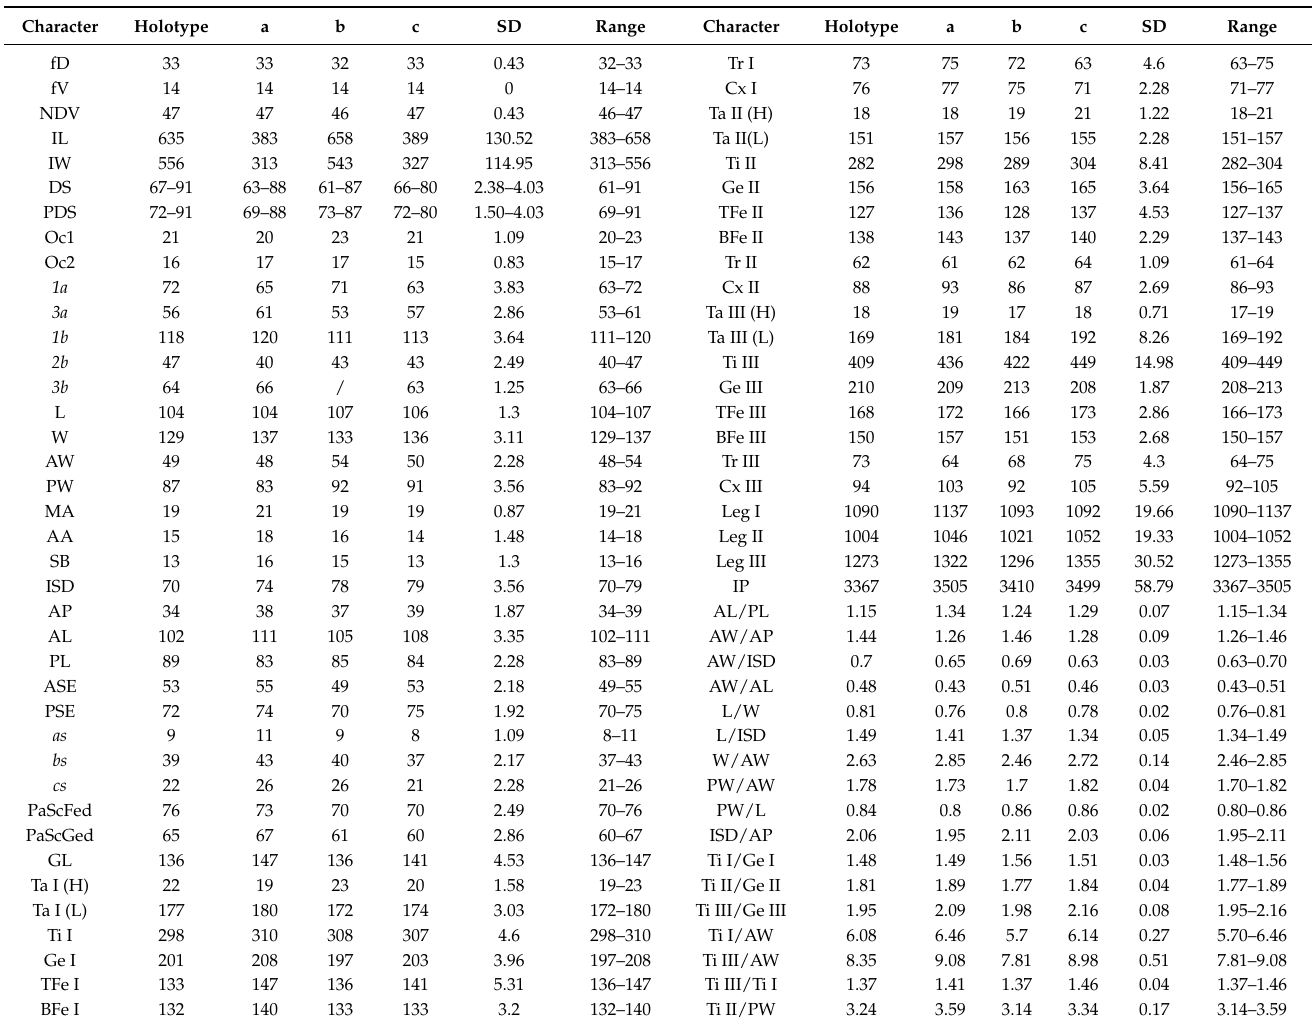
Table 2. Measurements of Erythraeus ( Erythraeus ) kunyuensis sp. nov. (larvae, a–c =